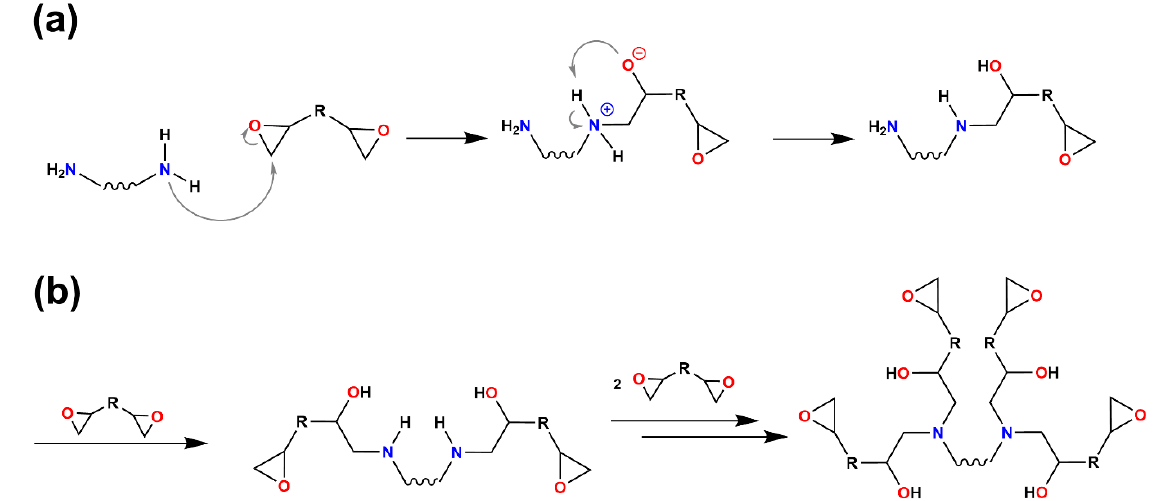
Figure 3. (a) Schematic representation of the mechanism of the epoxy-amine curing reaction. (b) Formation of crosslinked polymer networks.